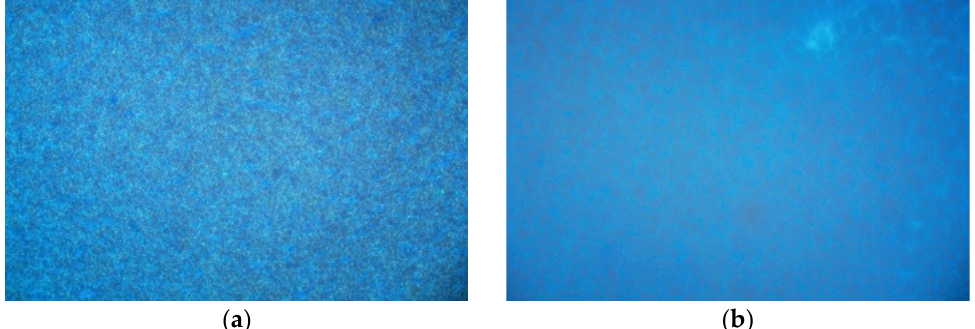
Figure 9. Fluorescent micro-structure of WE/A with 20% WER ( a ) 1 h; ( b ) 48 h.